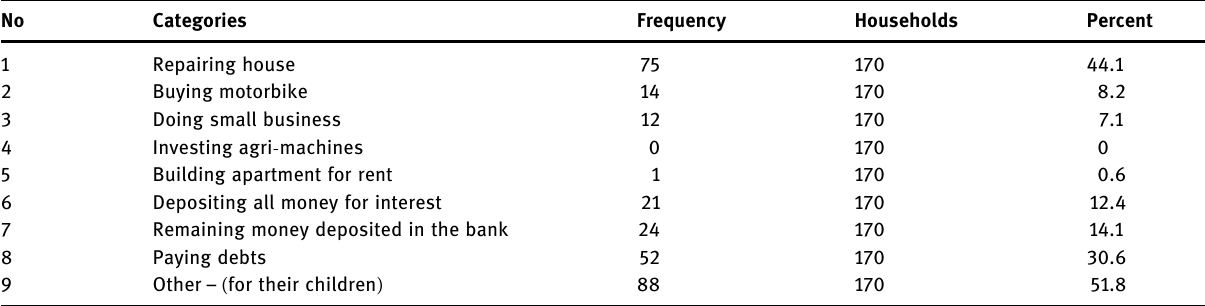
Table 4: How to use compensation money of households